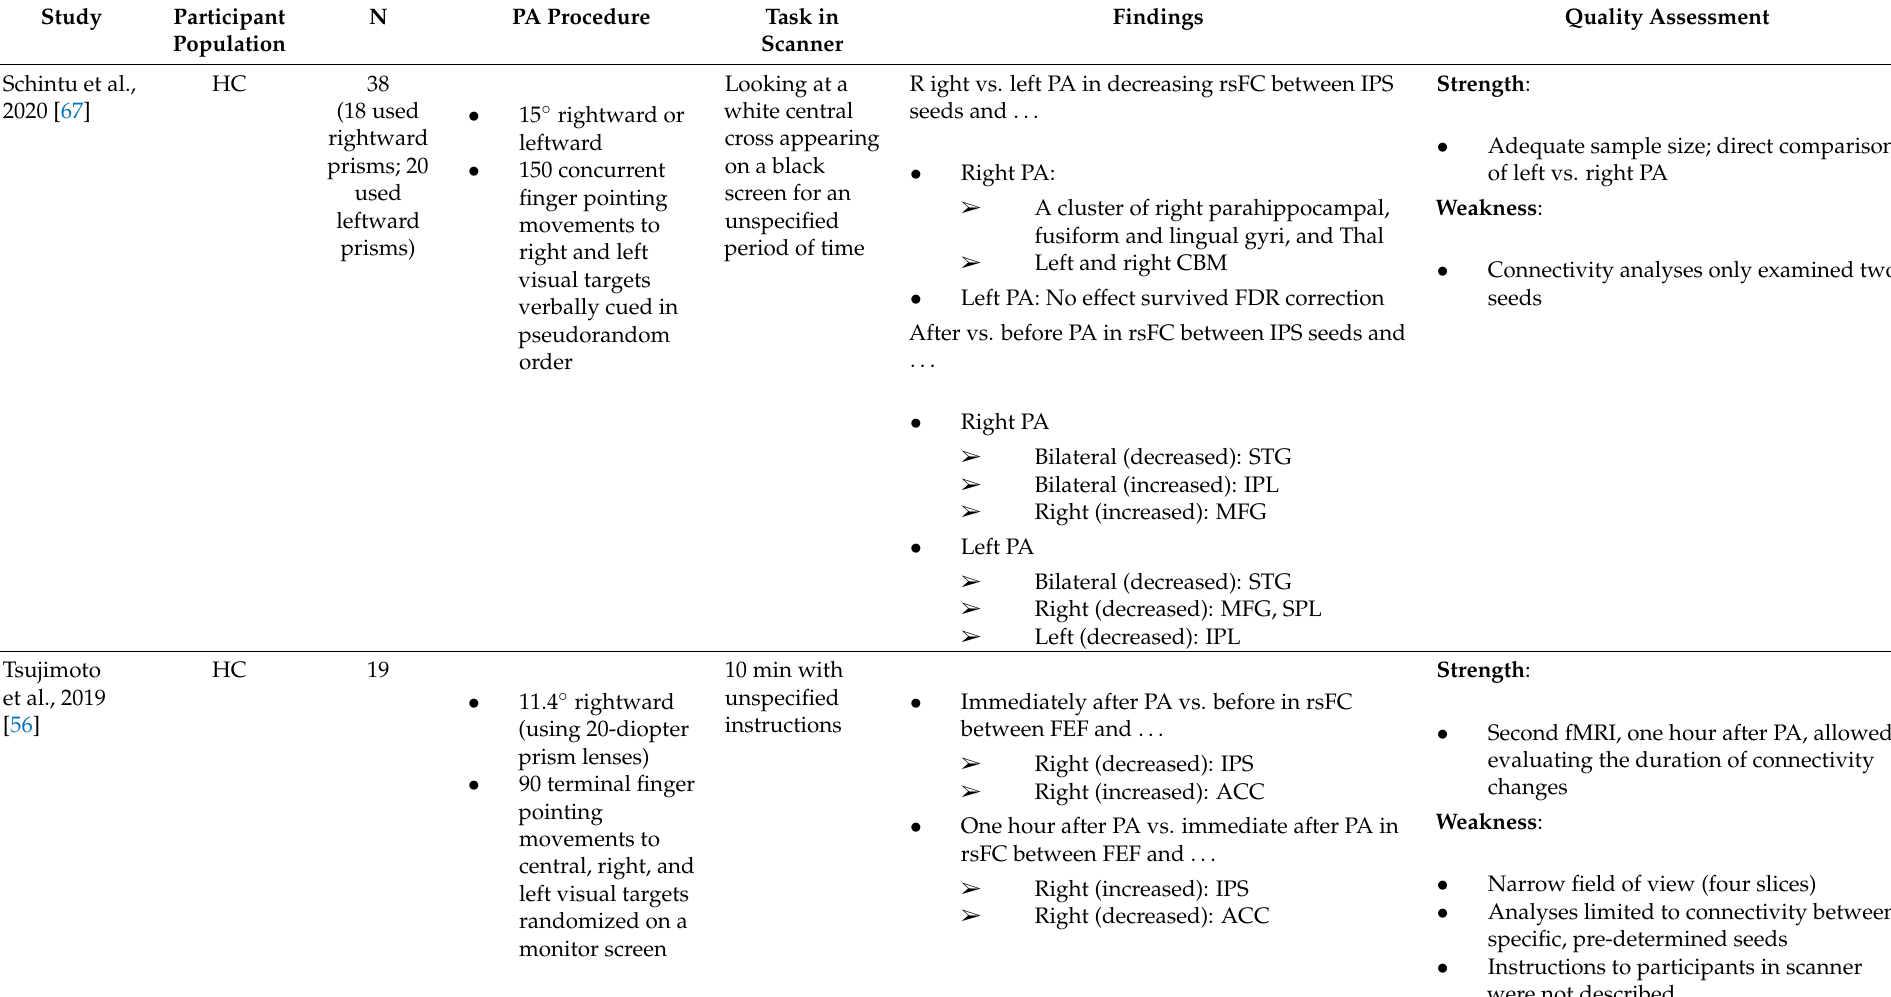
Table 2. Resting-state fMRI (rs-fMRI) studies of prism adaptation (PA). Four studies are included. Participants were scanned before and after PA. PA was conducted outside of scanner. Study Participant N PA Procedure Task in Findings Quality Assessment Population Scanner Schintu et